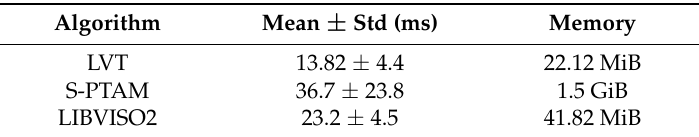
Table 2. Runtime performance measurements.